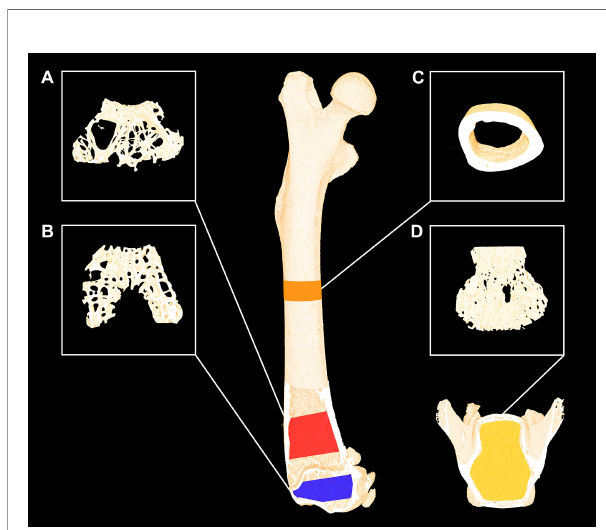
FIGURE 2 | Femoral and L4 bone sites investigated with µCT using an isotropic voxel size of 3.5 µm. (A) Red: 1,000- m m-high volume of interest (VOI) at the distal femoral metaphysis. (B) Blue: 490- m m-high VOI at the distal femoral epiphysis. (C) Orange: 820- m m-high VOI at the femoral mid- diaphysis. (D) Yellow: 2000-µm-high VOI at the L4 vertebral body. Dimensions are not to